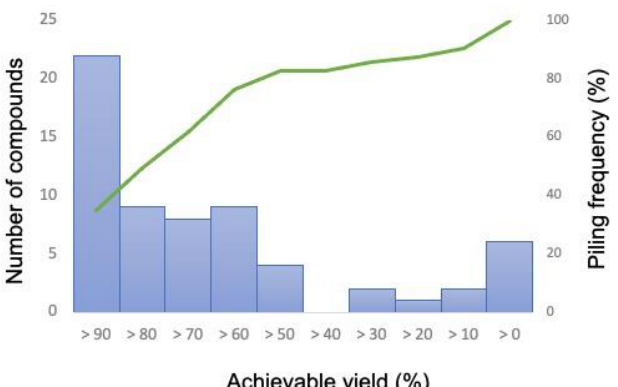
Figure 2. Distribution of the number of compounds that achieved production yield (left axis) and piling frequency (right axis) upon executing the AERITH algorithm. The percentage of yields that can be achieved with the combination of the deletion reactions is represented in units of 10% with respect to the theoretical production yields of each compound (Supplementary Table S2). The frequencies of the number of compounds satisfying these yields and the frequencies by accumulation from high productivity are also shown.